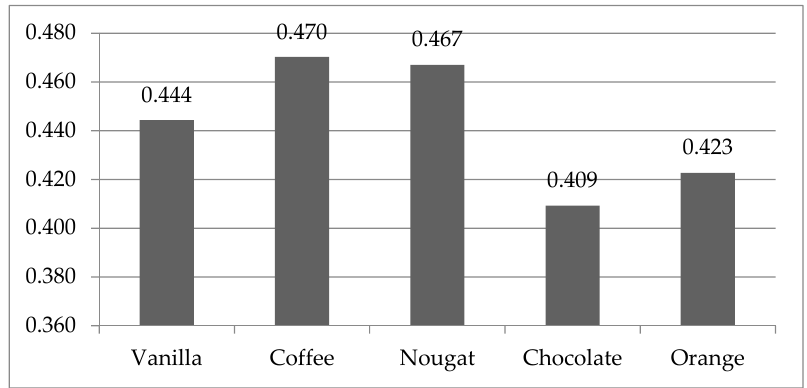
Figure 8. Comparison of excitement scores due to different aromas on emotional response.